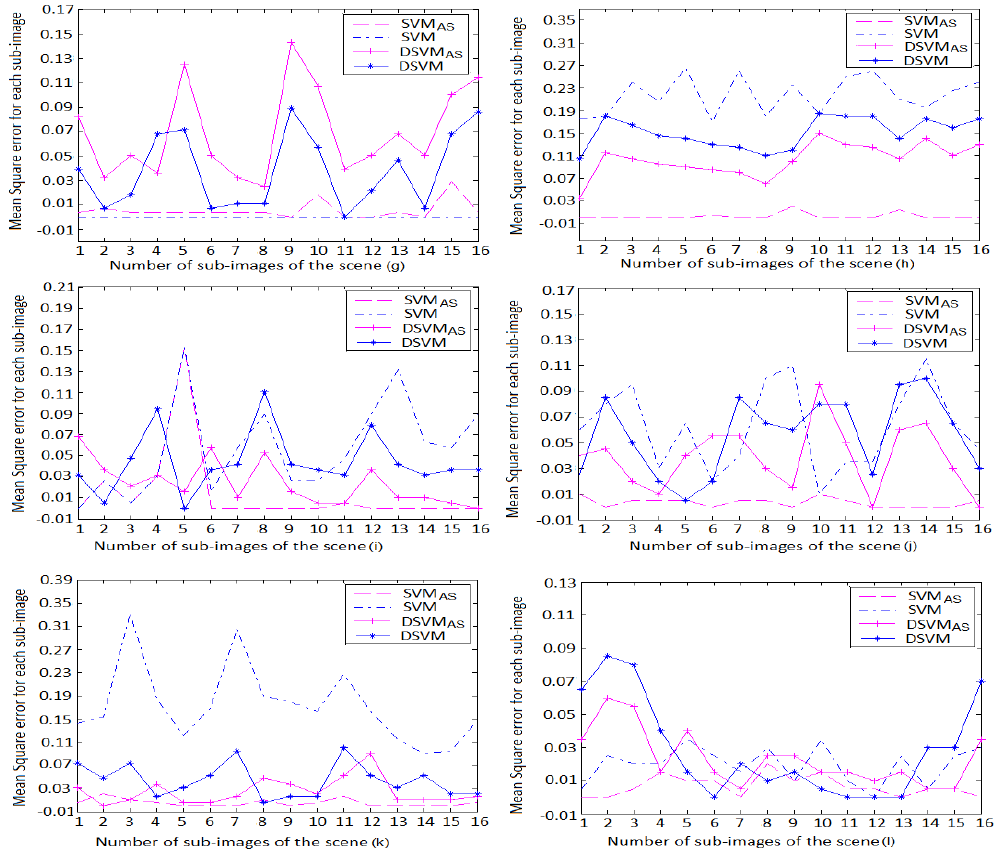
Figure 11. Variation of the mean square error for the sub-images of the 800 × 800 resolution scenes. It is shown that the SVM AS model gives the best performance on the scenes ( h – l ). We also found that DSVM AS provides mean square errors less than SVM and DSVM on the scenes ( h – l ). However, the DSVM model assures higher performance than DSVM AS on the learning scene ( g